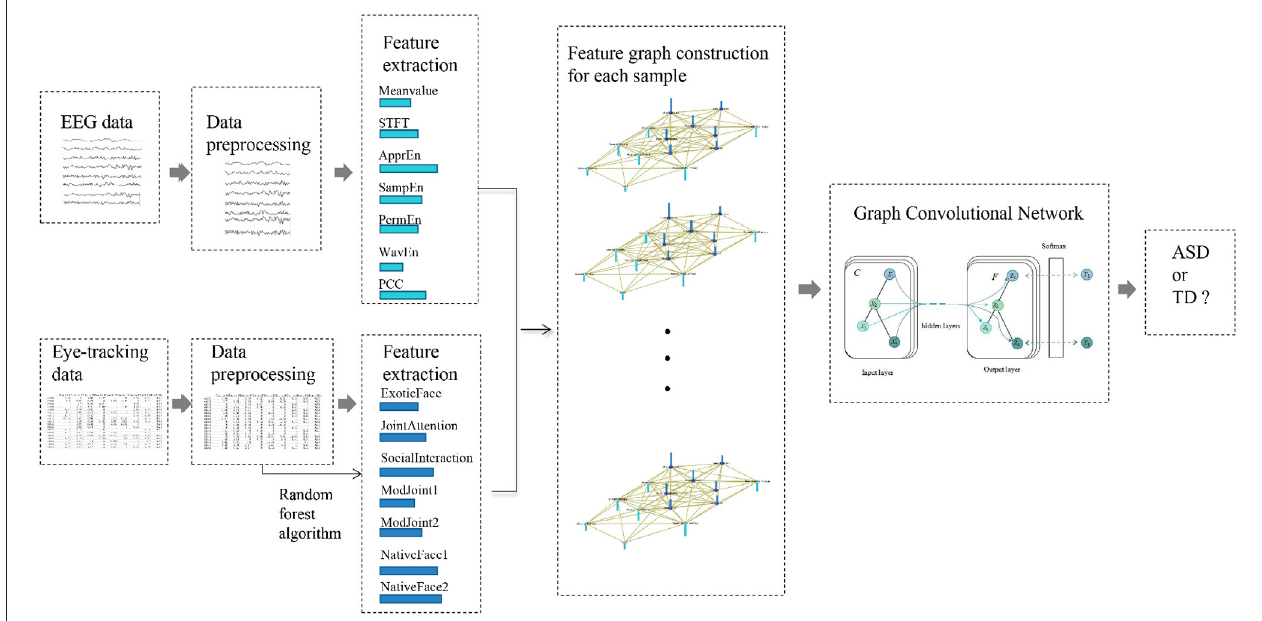
FIGURE 1 | Overall design of the proposed method. The method mainly includes four parts: (1) data preprocessing for EEG data and eye-tracking data separately; (2) feature extraction; (3) feature graph construction for each sample; (4) graph convolution network for ASD evaluation.